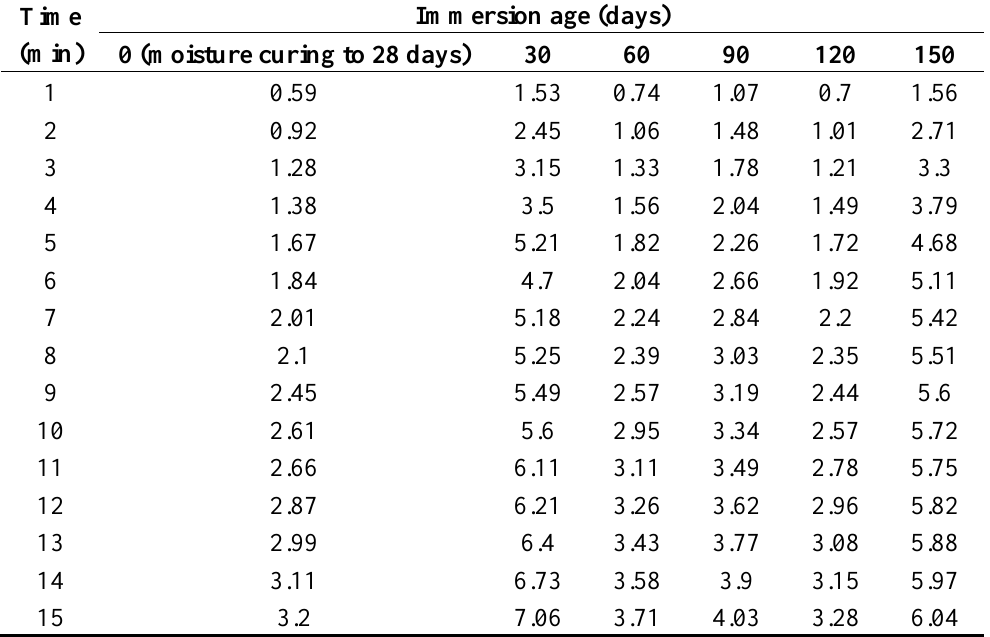
Table 1. Water seepage volume (10 −7 m 3 ) recorded within 15 min Autoclam tests on concrete at different immersion